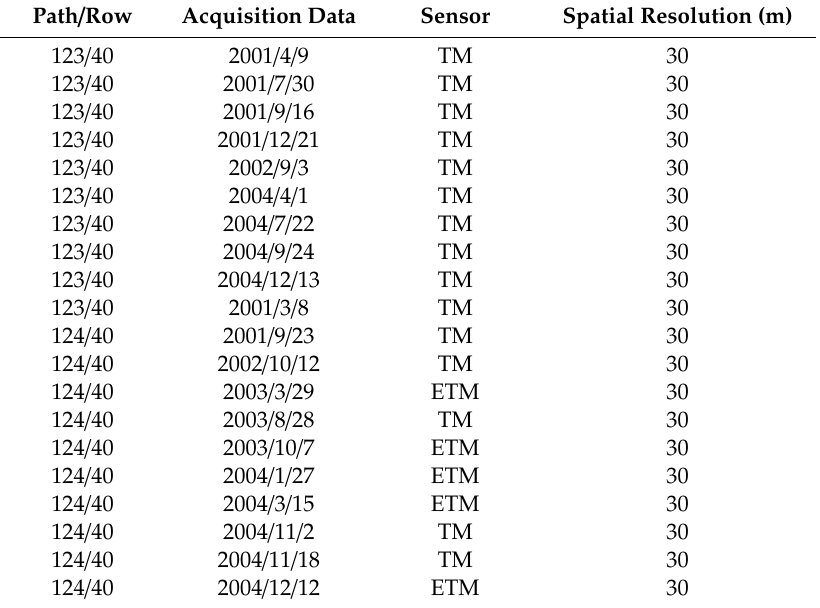
Table 1. Date of the remote sensing image and the